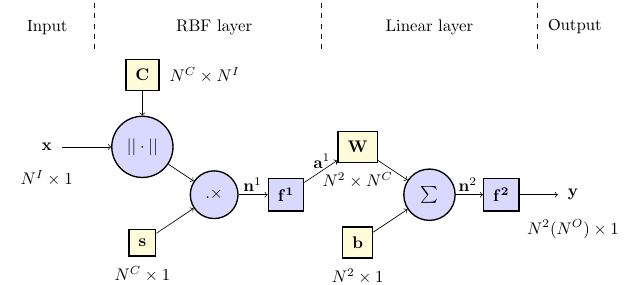
Figure 3. Radial basis function neural network.